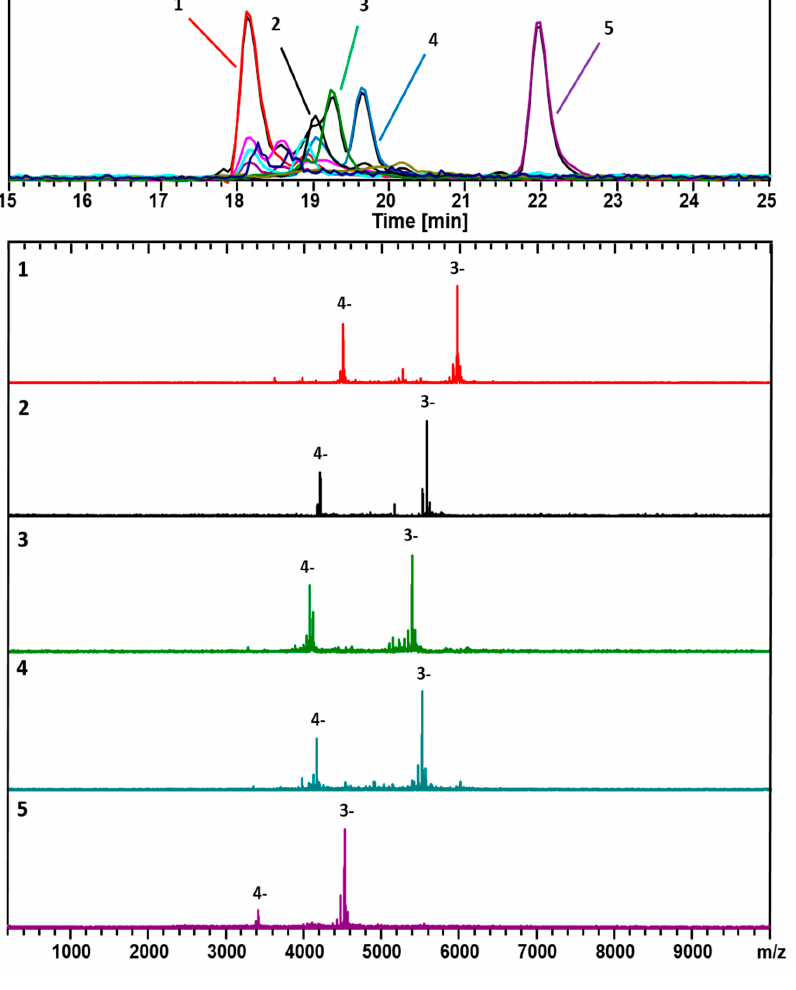
Figure 1. ESI-coupled LC-MS analysis of Au / 3-MBA clusters from the Azubel-preparation. Detection is set for negative ions, under conditions that generate mainly 3 − and 4 − charge states. The top frame shows the chromatograms, i.e., the base peak chromatogram ( m / z 100–10,000), and an extracted-ion chromatogram (EIC) for each identified component. The color-coded EIC chromatographic peaks track with the coded and numbered mass spectra listed herein with compositions assigned as follows: (1, Red) (67, 30), 17.8 kDa; (2, Black) (60, 31), 16.6 kDa; (3, Green) (58, 30), 16.0 kDa; (4, Blue) (60, 30), 16.4 kDa; and (5, Purple) (48, 26), 13.4 kDa. The fine-structure of the (67, 30) 3 − complexes is presented in Figure S1.